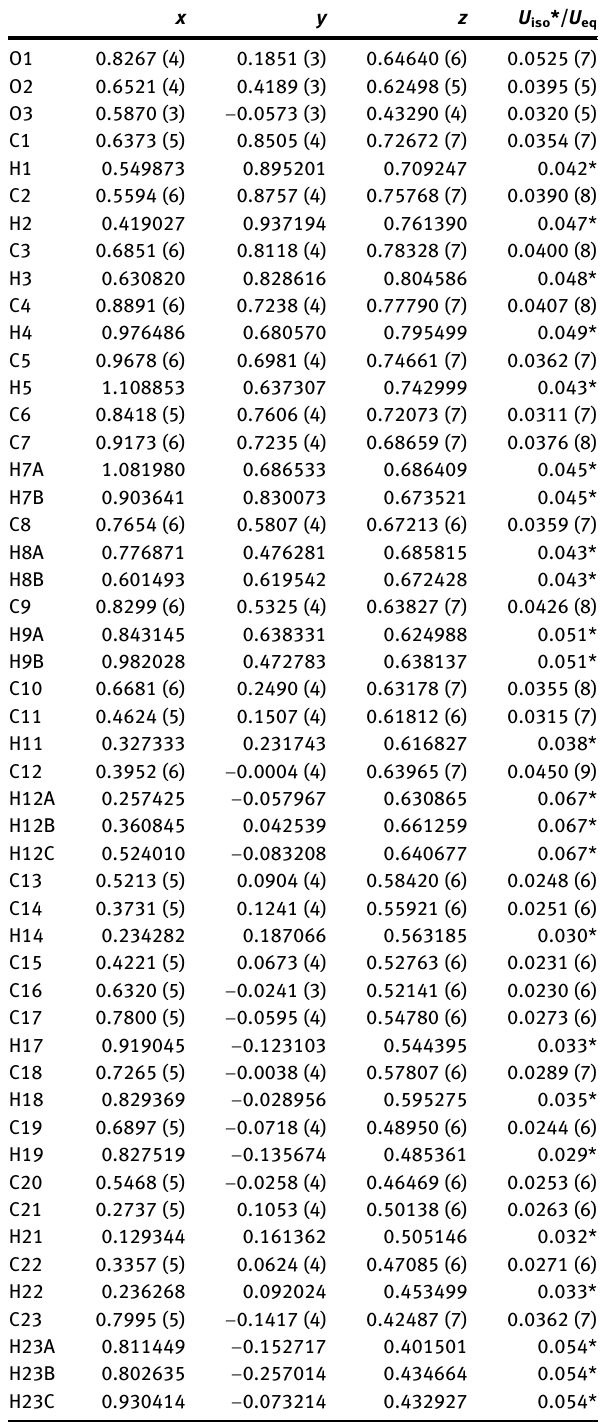
Table  : Fractional atomic coordinates and isotropic or equivalent isotropic displacement parameters (Å 